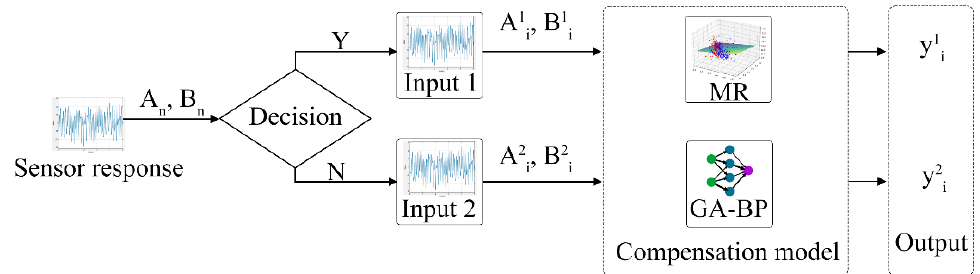
Figure 3. Flow compensation model of pumping electronic nose, where A mn is NO sensor response data; B m n is flow sensor collecting data; and m and n are group number and serial number, respectively.